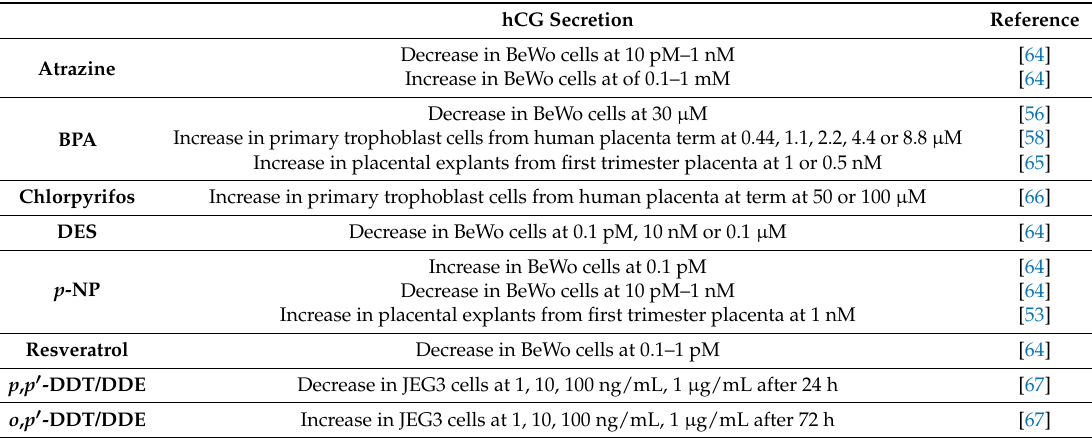
Table 1. Disruption of hCG (human chorionic gonadotropin) secretion by human placenta/trophoblast cells exposed to various EDCs (endocrine disrupting chemicals) at different concentrations and